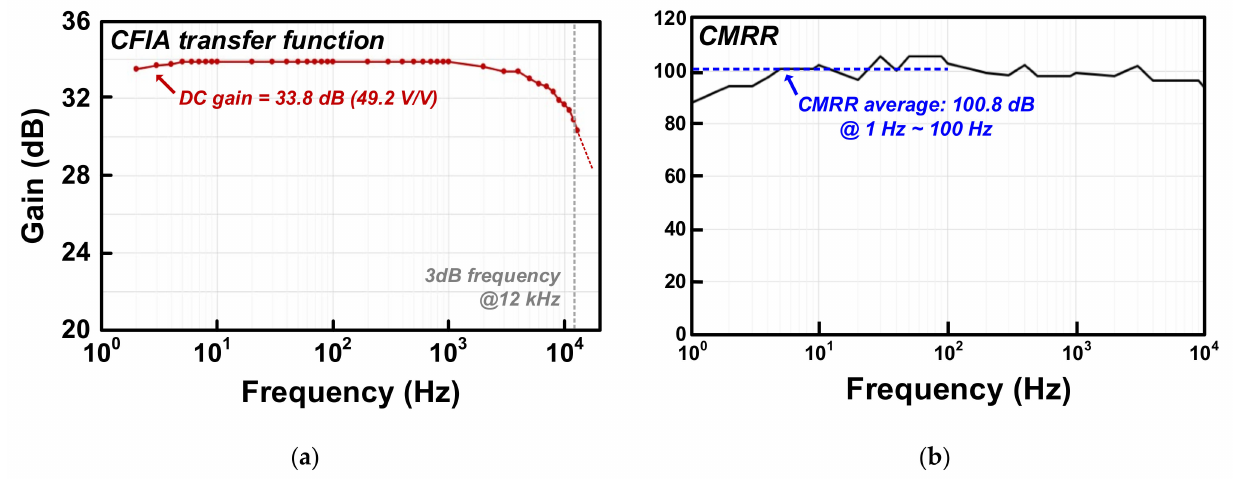
Figure 15. ( a ) Sine wave amplification and ( b ) chopper clock transient response measurement result for the proposed CFIA.